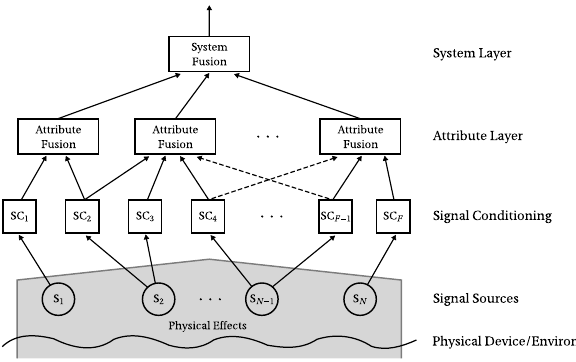
Figure 1. Architecture of the multilayer attribute-based conflict-reducing observation system MACRO